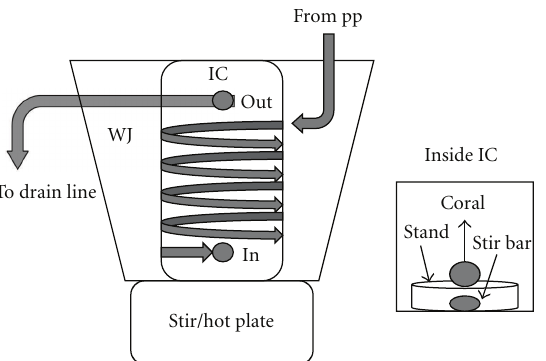
Figure 2: Schematic representation of a single incubation chamber (IC) and water jacket (WJ). Upper arrows represent the direction of water flow. Arrows encircling the IC represent tubing bathed within the WJ. Inset: magnified view of contents within an